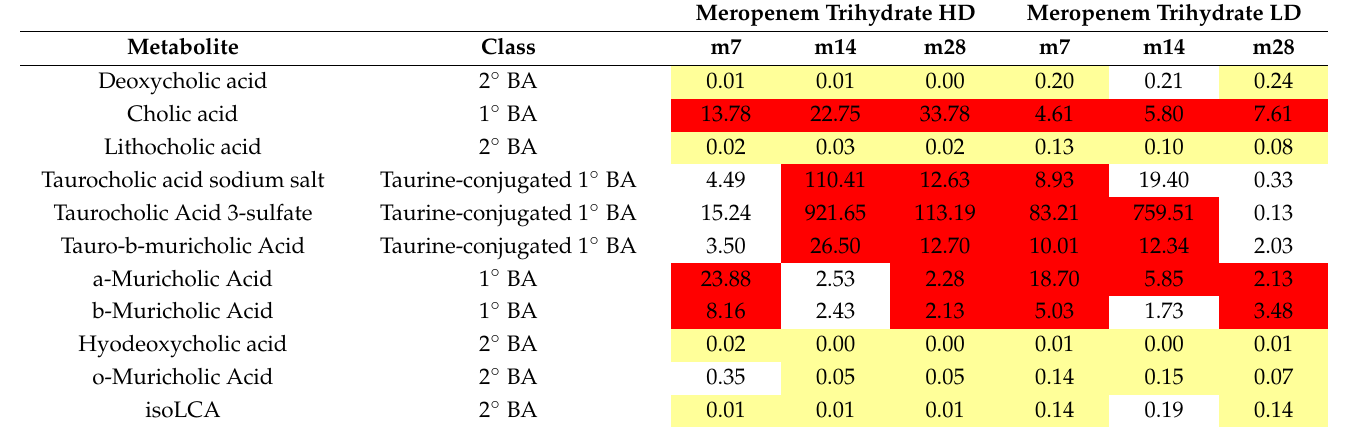
Table 3. Meropenem-induced BA fold changes in feces of male Wistar rats (N = 5 per group) dosed with 100 (LD) and 300 (HD) mg/kg bw/day observed on days 7, 14, and 28 (m7, m14, and m28). Statistically significant changes (Welch t -test; p -value < 0.05) are shown where red boxes mean an increase, yellow boxes mean a significant decrease, and white boxes indicate an insignificant change in the respective fecal